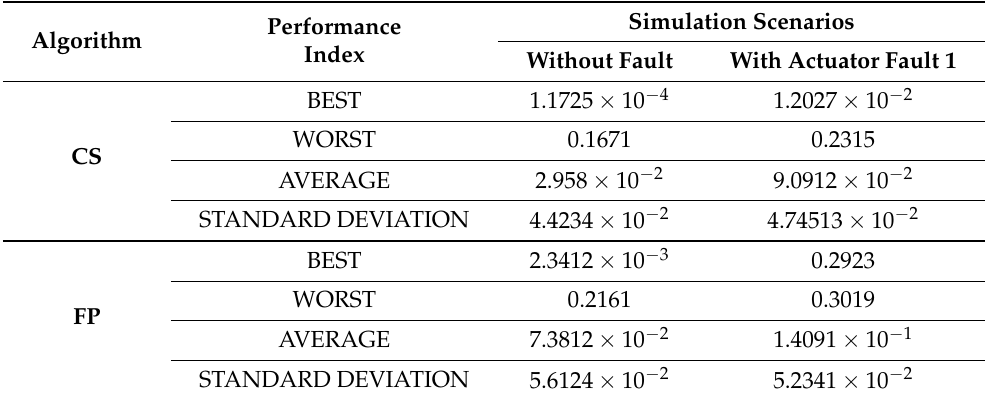
Table 3. Results of metrics of Mean Square Error (MSE) values to found by CS and FP algorithm using ST2FIS.